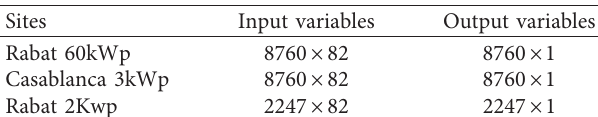
Table 5: Summary of locations and input/output sizes used to feed the forecasting models.